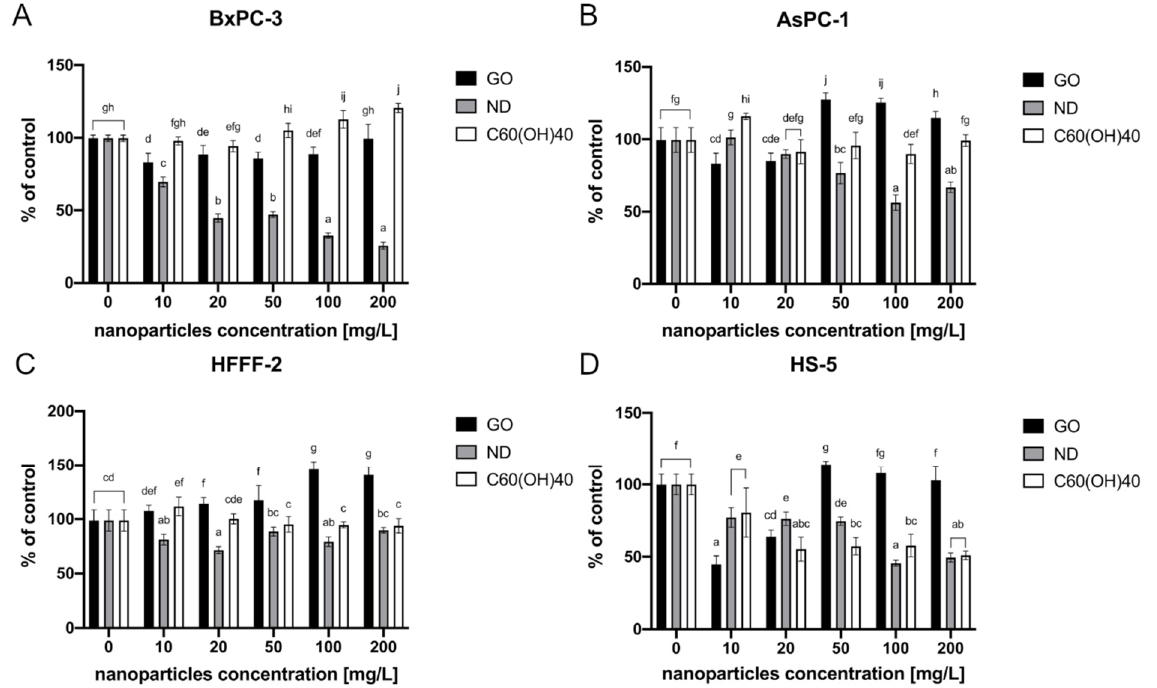
Figure 5. The cell viability after a 24-h incubation period with carbon-based nanomaterials as determined by an MTT assay. The results are presented as a percentage of the control (mean with standard deviation). Different letters above the columns indicate statistically significant differences between the groups ( p ≤ 0.05). Capital letters refers to different cell lines: ( A ) BxPC-3; ( B ) AsPC-1; ( C ) HFFF-2; and ( D ) HS-5.